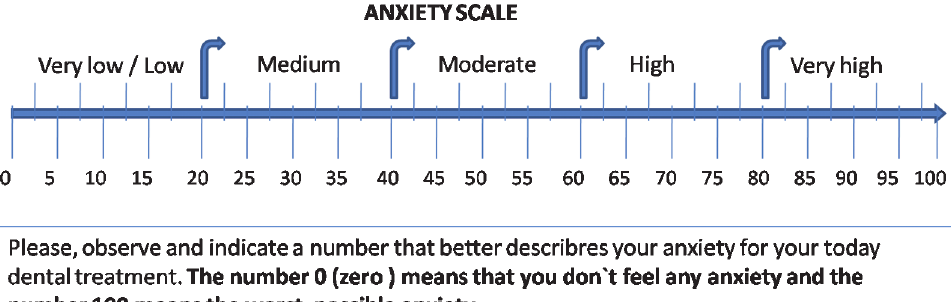
Figure 1 - Numerical scale used to subjectively score patient anxiety level.